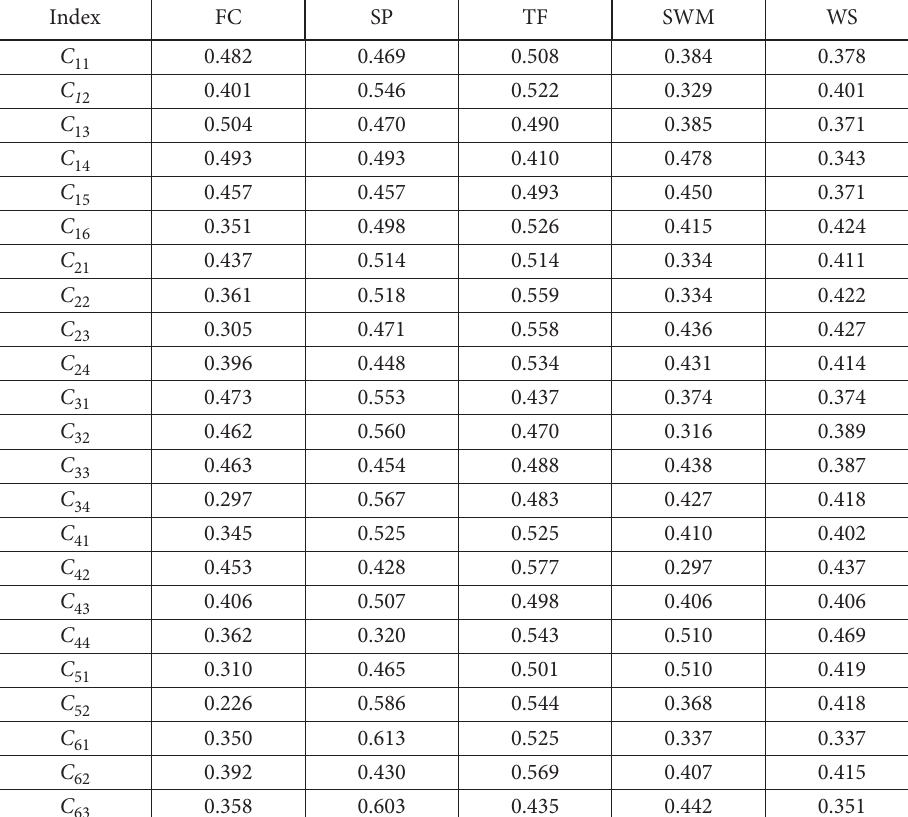
Table 8. Normalized matrix of performance